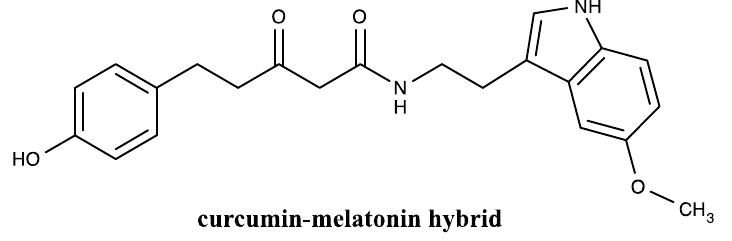
Figure 5. Chemical structure of curcumin hybrid compound applied in Alzheimer’s